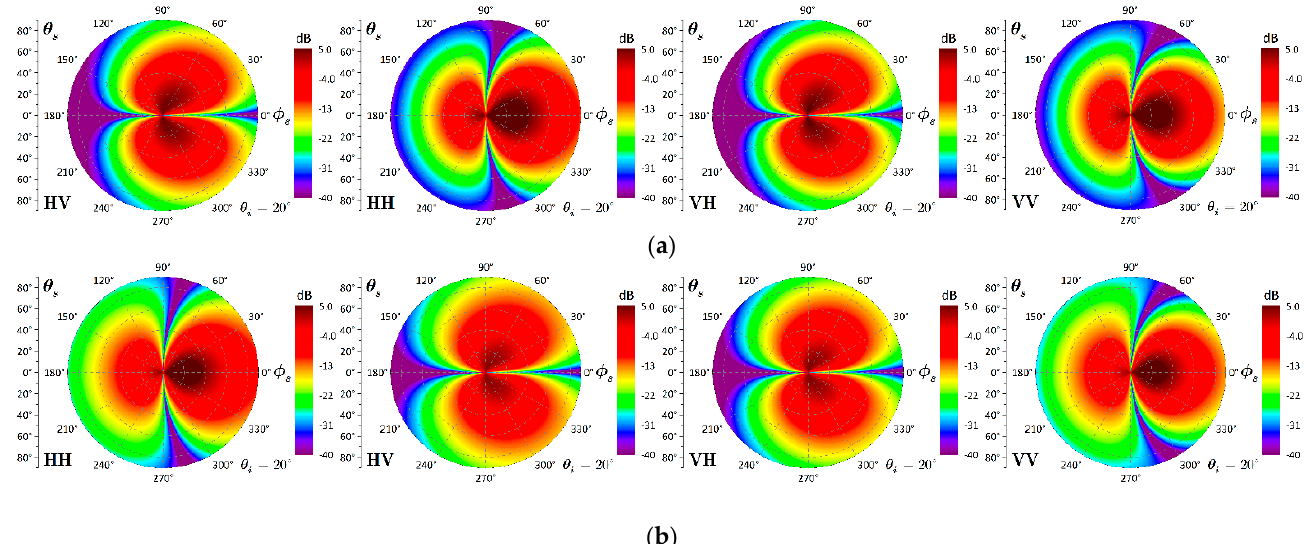
Figure 7. Comparison of bistatic incoherent scattering along the azimuthal direction for four types of surfaces: Gau HPD and Gau PSD, Gau HPD and Exp PSD, Exp HPD and Gau PSD, Exp HPD and Exp PSD. The related parameters are kl = 8, k σ = 1.0, ε r = 15 − j 1.5, θ i = 20 ◦ , θ s = 20 ◦ . ( a ) HH polarization, ( b ) VV polarization.